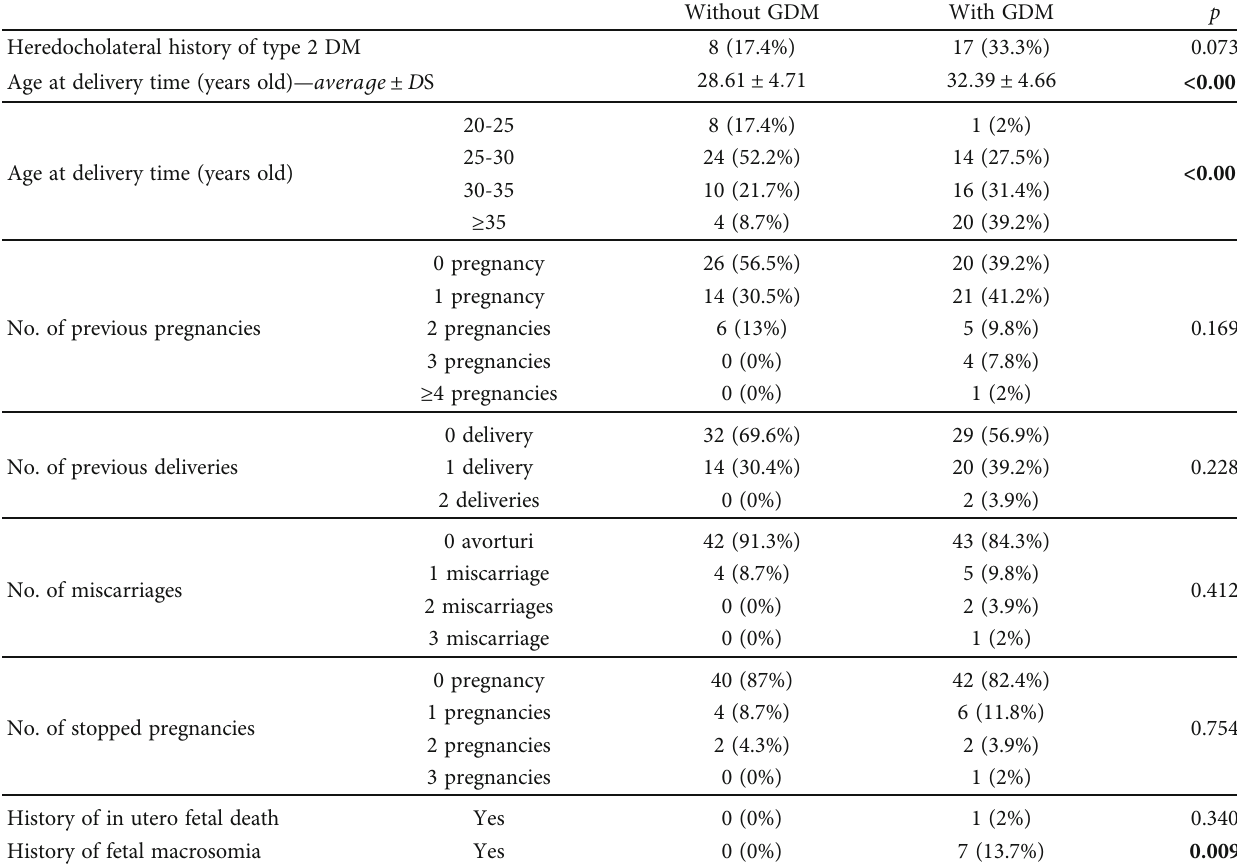
Table 2: Physiological heredocholateral and personal history.